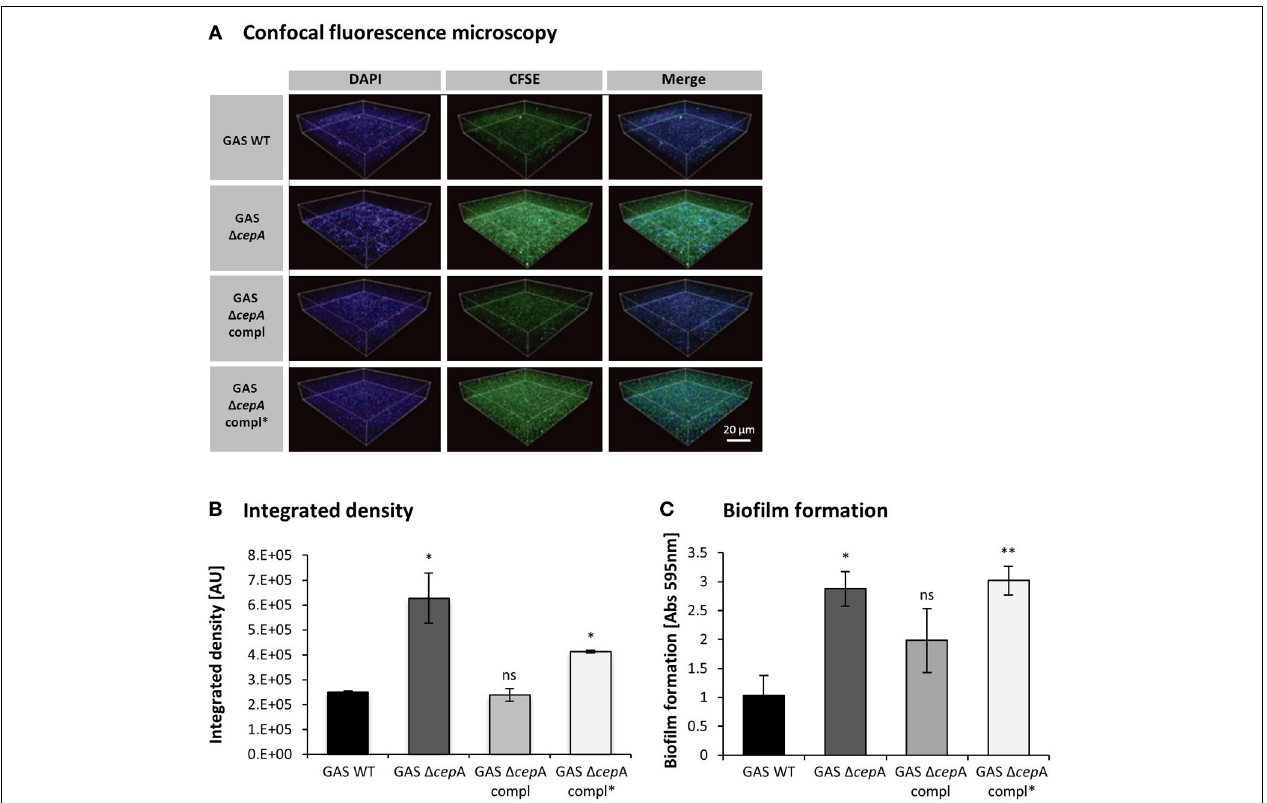
FIGURE 3 | Decreased GAS cell surface attachment and biofilm formation in the presence of SpyCEP. (A) Microscopy analysis of GAS attached to the surface of human pharyngeal cells. GAS strains and Detroit-562 cells were stained with CFSE (green) and DAPI (blue) respectively and attachment was assessed using a fluorescence confocal laser scanning microscope. The scale bar in the confocal images represents 20 μ m. (B) Integrated densities of attached bacteria obtained from confocal images were evaluated using ImageJ. The integrated density is measured in arbitrary